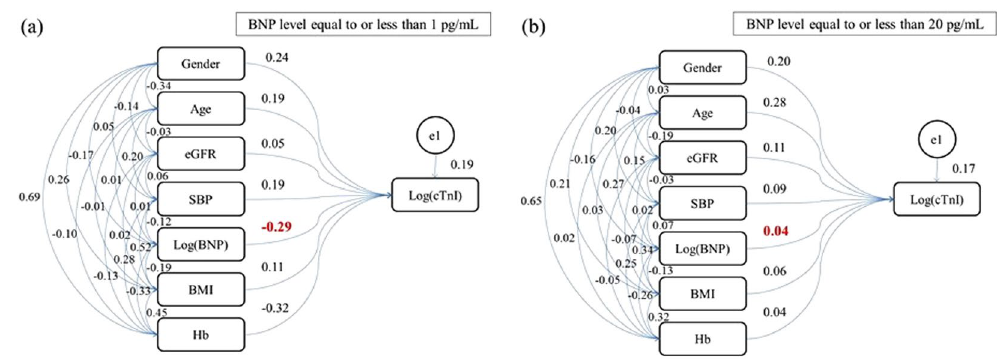
Figure 3. ( a ) Path diagram against log(cTnI) in subjects with BNP levels equal to or lower than 1 pg/mL (low BNP group, N = 81). ( b ) Path diagram against log(cTnI) for subjects with BNP levels equal to or lower than 20 pg/mL (control group, N = 1,860). The coefficient of standardized regressions (direct effects) of each path is shown next to the path. cTnI, cardiac troponin I; eGFR, estimated glomerular filtration rate; SBP, systolic blood pressure; BNP, B-type natriuretic peptide; BMI, body mass index; Hb, haemoglobin.